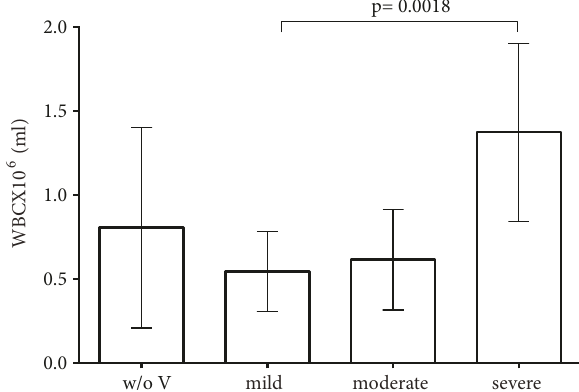
Figure 1: Concentration of WBC (10 6 /ml) in accordance with the thread length of viscosity (mild, moderate, and severe) as the HV group; w/o V: semen without